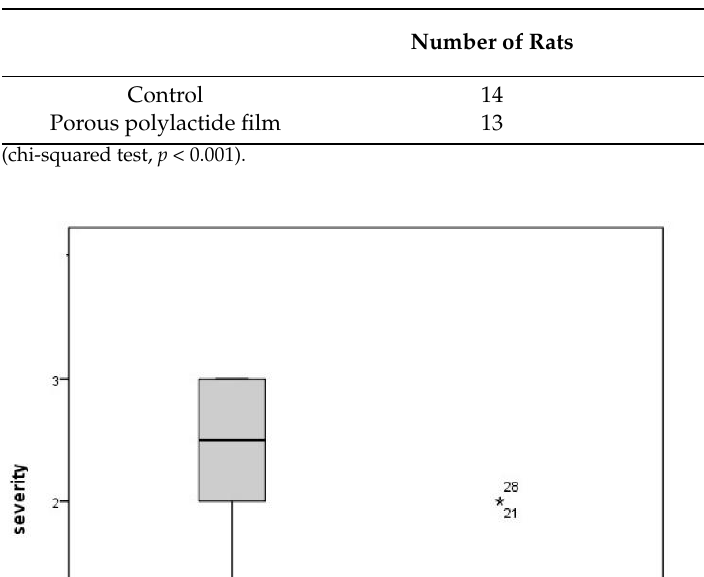
Figure 9. Photographs of the test group. ( A ) Adhesions between the incision in the abdominal wall and other tissues can be observed. ( B ) There are fewer adhesions between the cecum and ab- dominal wall. Note: “C” represents cecum, and “I” represents incision site. Table 2. Presence of adhesion in the rat cecum abrasion model. 3 (23.1%)